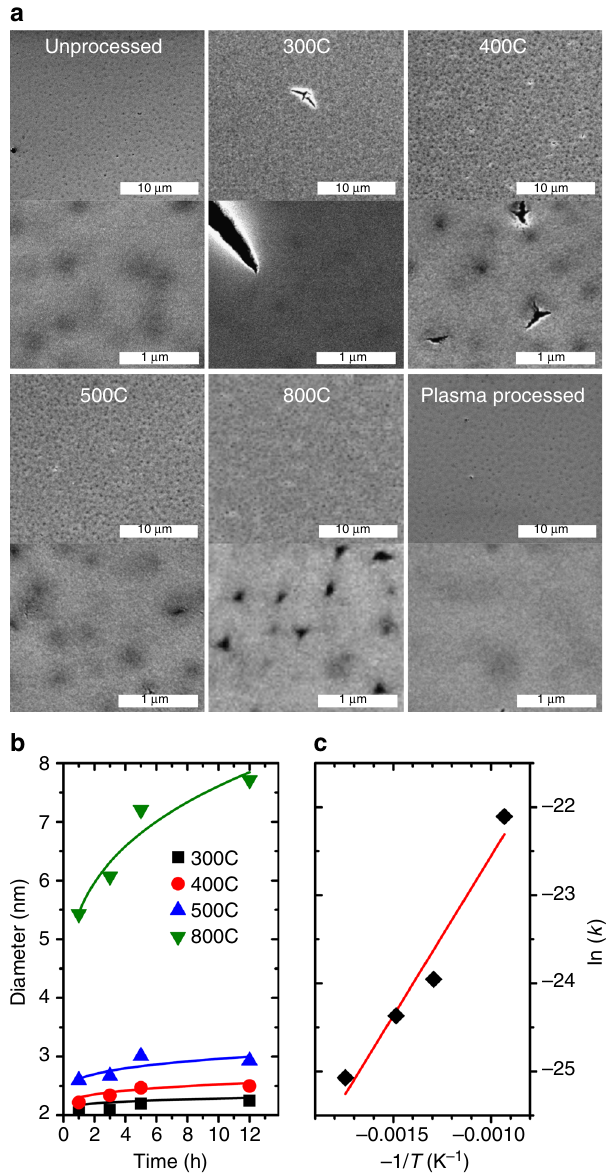
Fig. 4 Surface characterization and growth kinetics during calcination. a SEM micrographs of the top surface of the unprocessed, calcined (12 h), and plasma-processed fi lms. Plasma processing produces smooth fi lms compared to calcination, which forms deep clefts, though the disordered structure of the fi lm resists catastrophic cracking. b Crystallite size as a function of time at different calcination temperatures with Ostwald model fi t curves. c Arrhenius plot of the rate constants of grain (Fig. 4c). The activation energy of grain growth of the calcined − 1 CNAs (30 kJ mol ) is nearly four time smaller than the one measured in plasma-processed samples (111 kJ mol − 134 ). Lower activation energies suggest earlier growth/coarsening during calcination in comparison to the plasma-processed samples. Since grain growth is a surface-dominated process, the signi fi cant reduction in the activation energy suggests a signi fi cant change in the interface composition resulting from the incomplete oxida- tion of the ligands. While our results apply quantitatively to our model system, it is likely that qualitatively similar results occur in similarly